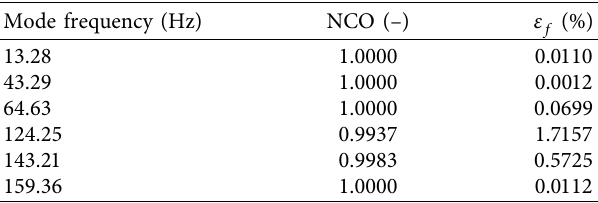
Table 2: Evaluation of the accuracy of the reduced